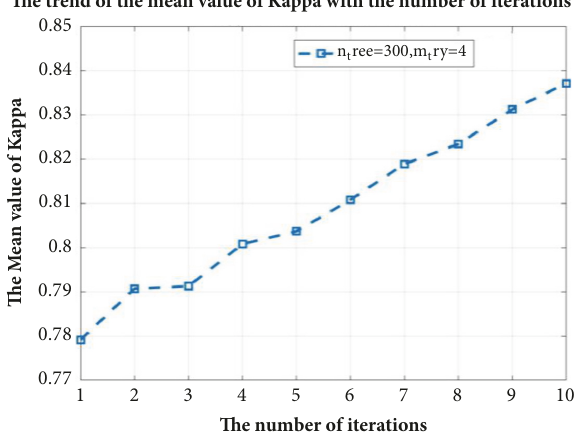
Figure27:Classificationkappatrendofdifferentinitialanditerative condition of AVIRIS data for method 1.